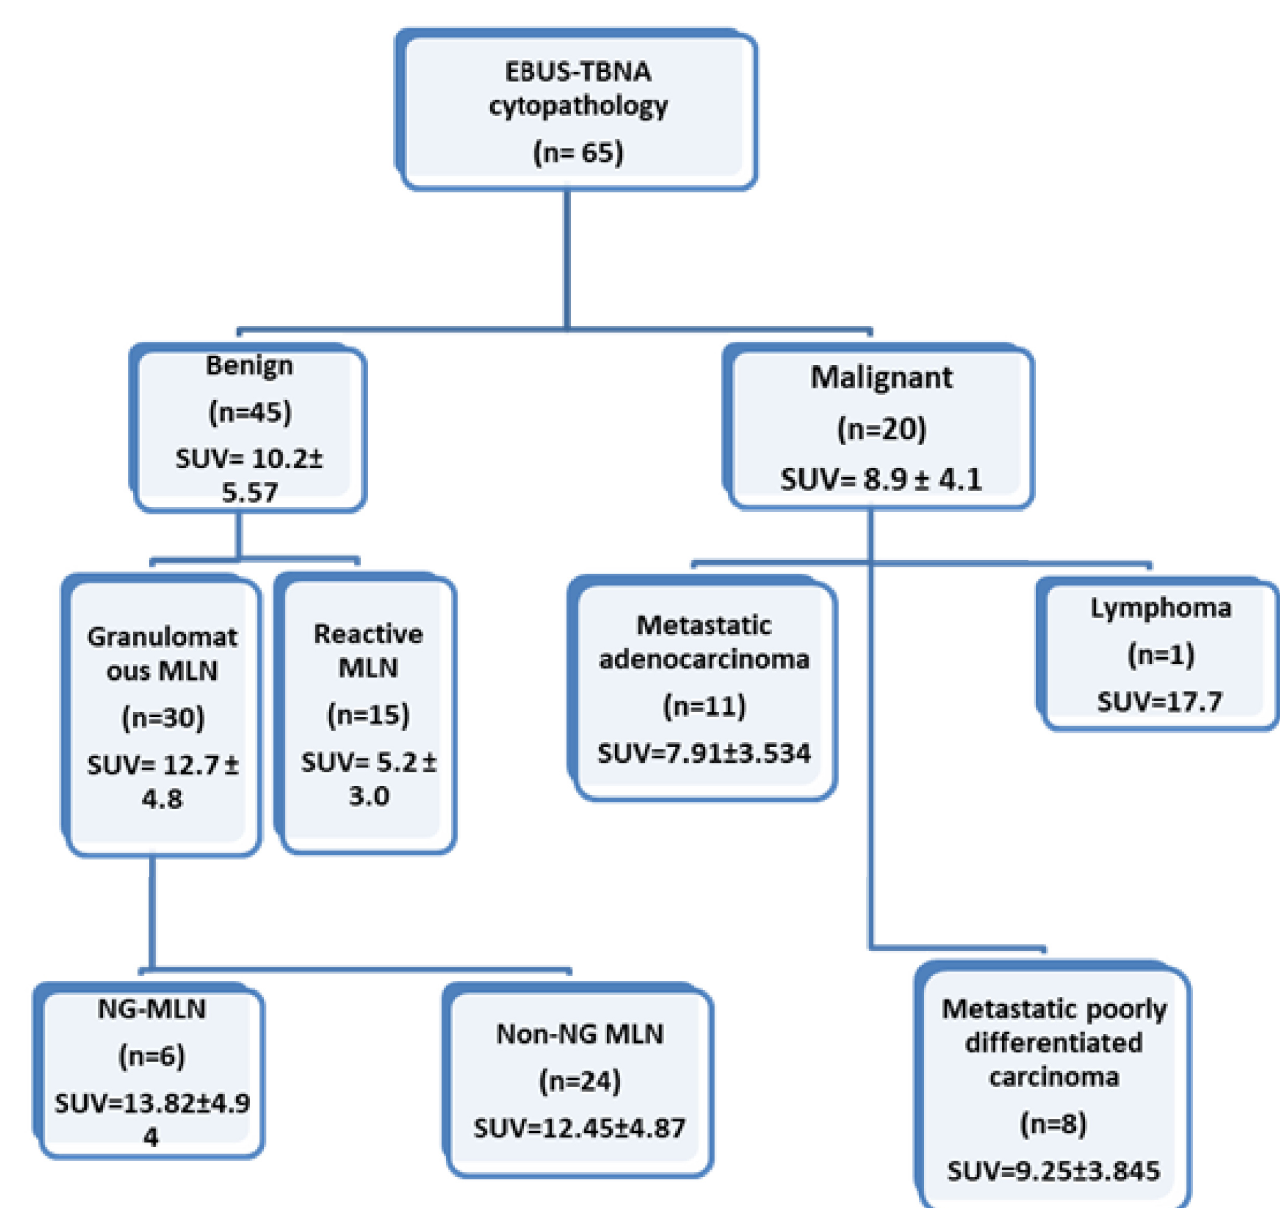
Fig 1. Results of 65 patients with HM-MLN EBUS-TBNA, with SUV in each group (mean ± SD): NG MLN: Necrotising granulomatous mediastinal lymph node. Non-NG MLN: Non Necrotising granulomatous mediastinal lymph node.